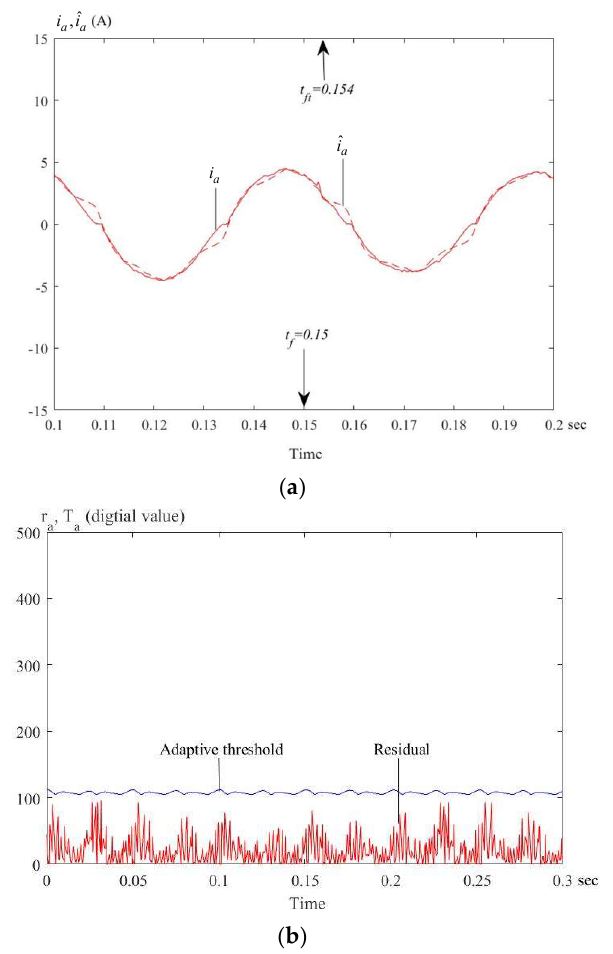
Figure 22. Measured results of the a -phase in normal operating conditions: ( a ) measured and estimated currents; ( b ) residual and adaptive threshold.